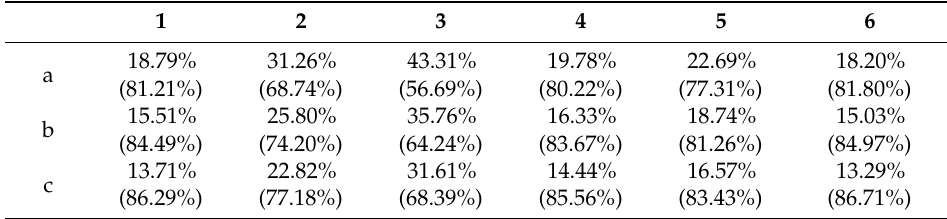
Table 4. Percentage contribution of resonance and inductive e ff ects for the substituted benzoic acids. The percentage for the inductive e ff ect is given in